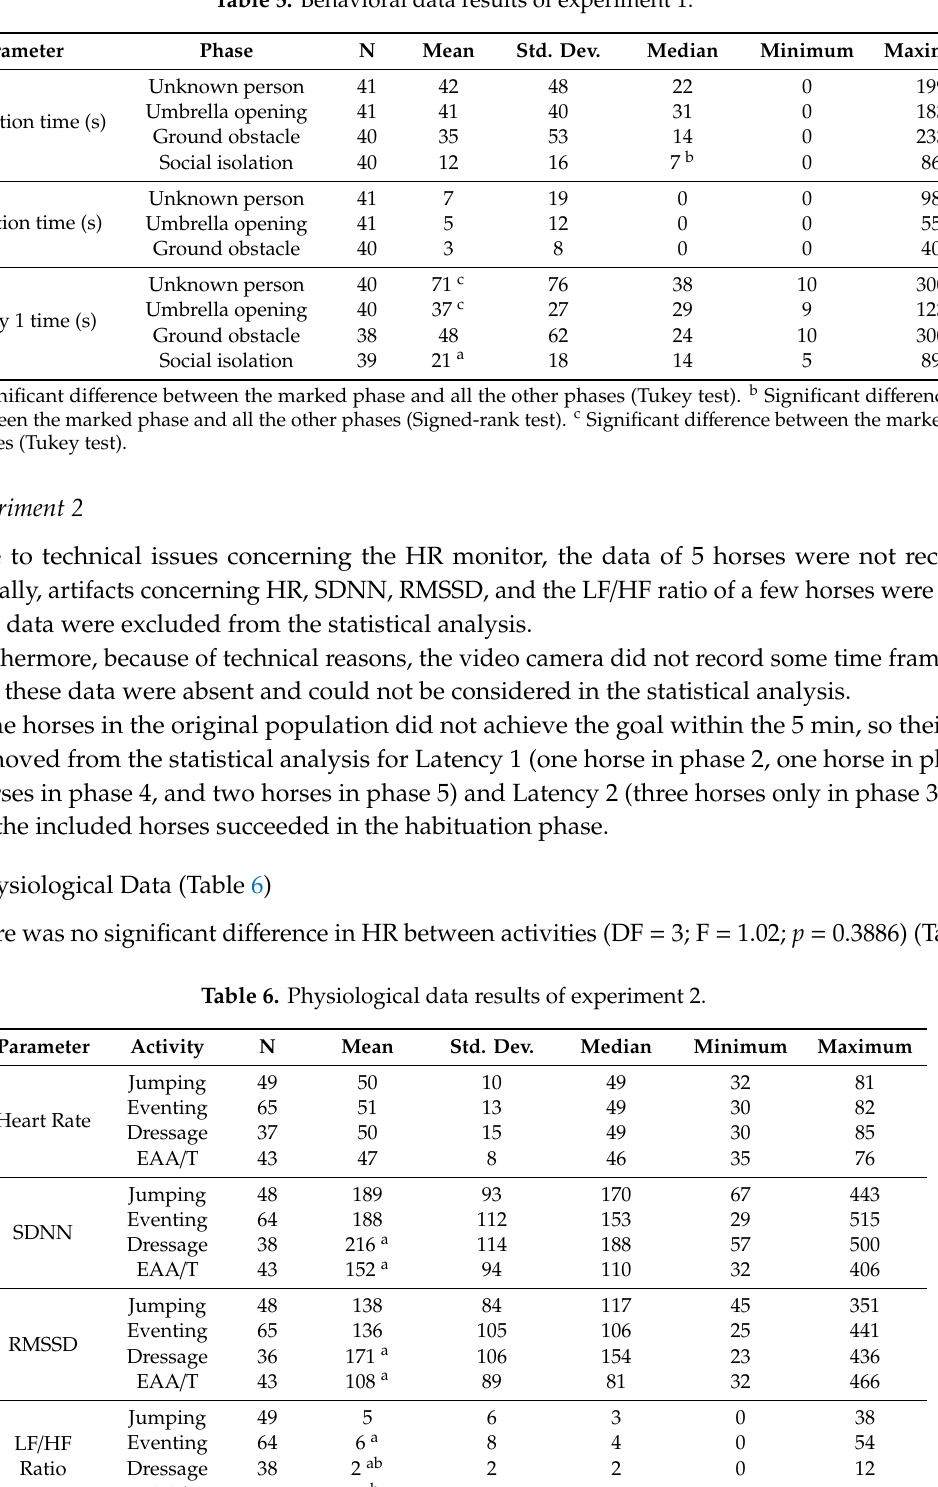
Table 5. Behavioral data results of experiment 1.